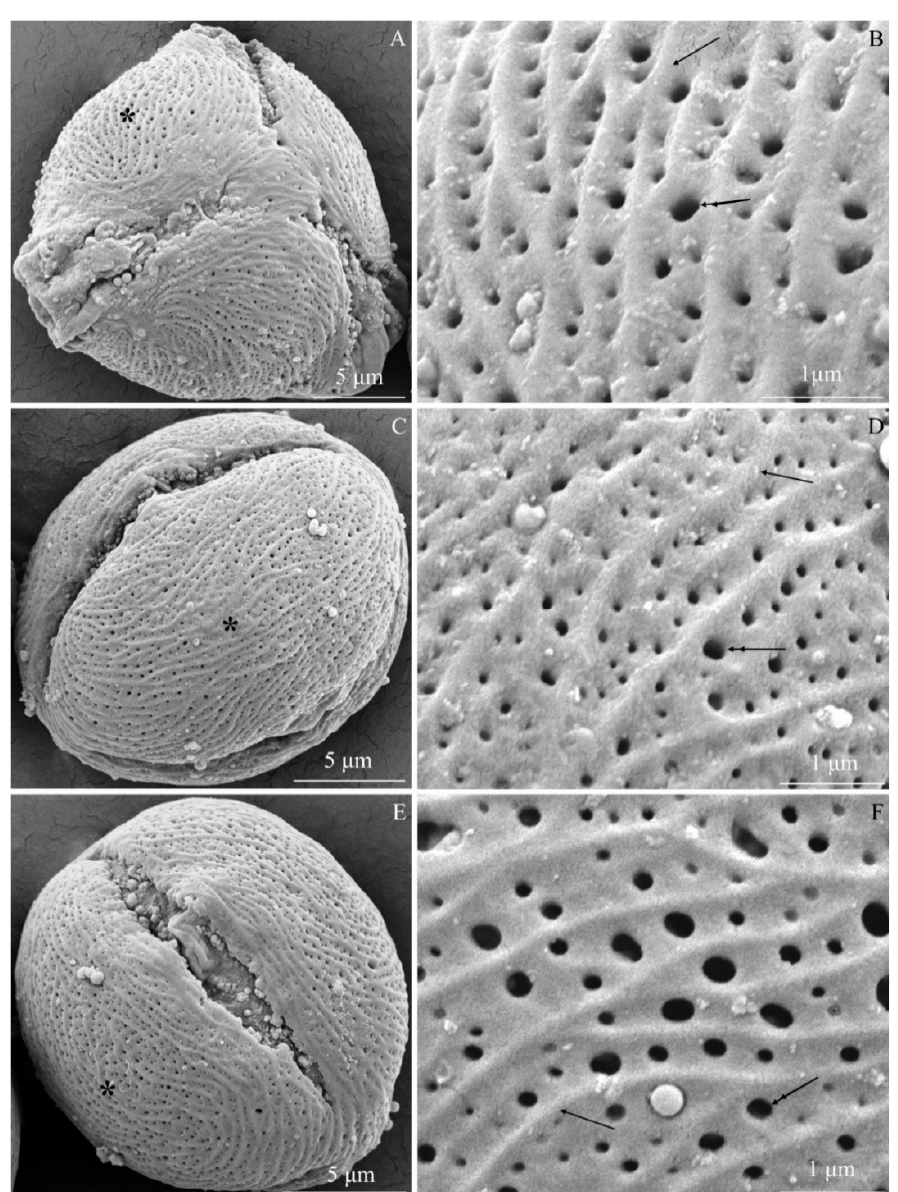
Figure 6. A – F . Pollen grains ( A , C , E ) and fragments of exine surface sculpture ( B , D , F ) in Rubus idaeus ‘Polka’: A , B —polar view, visible delicate outline of arcuate or branched muri in the apocolpium, distinct protuberances between colpi, perforations in colpi, ( B ) dense parallel to semicircular arrangement of muri, varied diameter of perforations arranged in rows between parallel muri; C , D —equatorial view, ( C ) colpi reaching the poles, numerous perforations, parallel arrangement of muri along the polar axis with a semicircular curve, ( D ) parallel arrangement of muri (arrow), varied diameter of perforations between muri; E —equatorial view of a grain, visible colpus reaching the poles, numerous perforations; F —parallel and branched muri (arrow), varied arrangement and diameter of perforations (double-headed arrow). A – F - SEM.